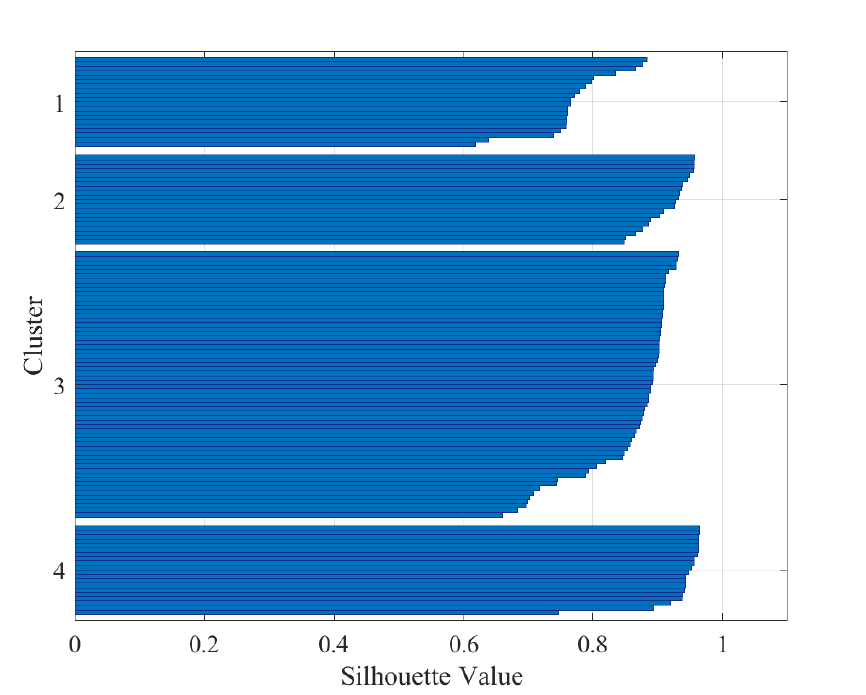
Figure 11. Silhouette plot of clustered stator current harmonics data with k = 4.